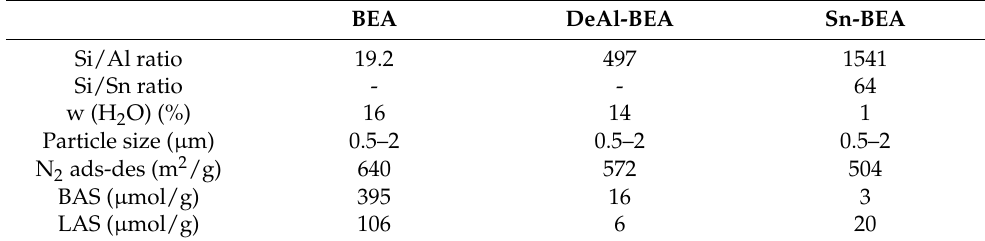
Table 1. Summary of BEA-19, DeAl-BEA, and Sn-BEA characterisation